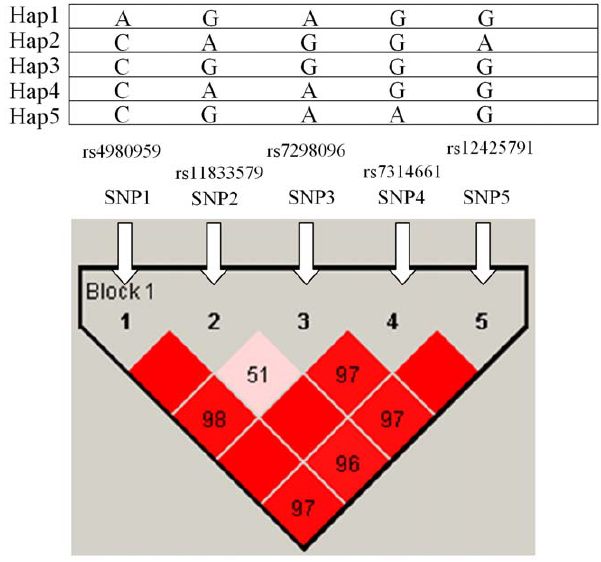
Figure 1. NINJ2 linkage disequilibrium plot. This plot was generated by Haploview program using the modified Gabriel et al. algorithm using data from this study. Five common haplotype (frequency $ 0.05) were identified and formed one block. The SNP name, e.g., SNP1, SNP2, etc., indicated five htSNP genotyped in this study. The level of pair-wise D’, which indicated the degree of linkage disequilibrium between two SNPs, was shown in the linkage disequilibrium structure in